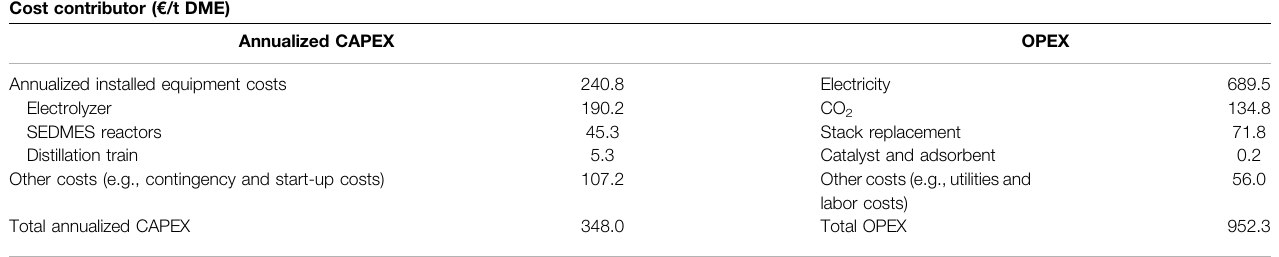
TABLE 7 | Breakdown of the costs contributors of the power-to-X technology DME production using SEDMES in euro per ton of DME. Cost contributor ( € /t DME)